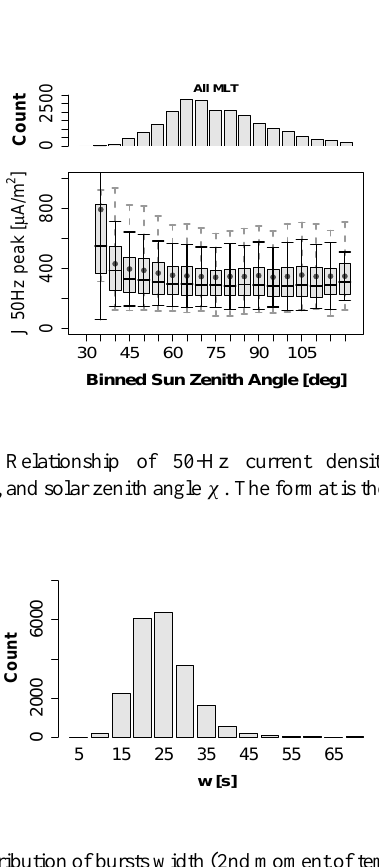
Fig. 13. Distribution of bursts width (2nd moment of temporal burst structure) in bins of 5s (15s correspond to 1 ◦ in latitude).